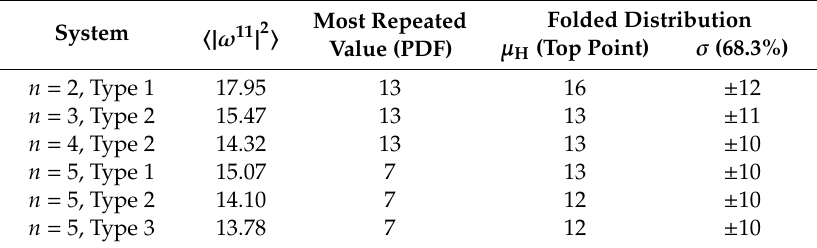
Table A17. Statistical parameters of SAW size for the FCC restricted lattice as a function of system characteristics (fixed: N = 11) for selected systems.